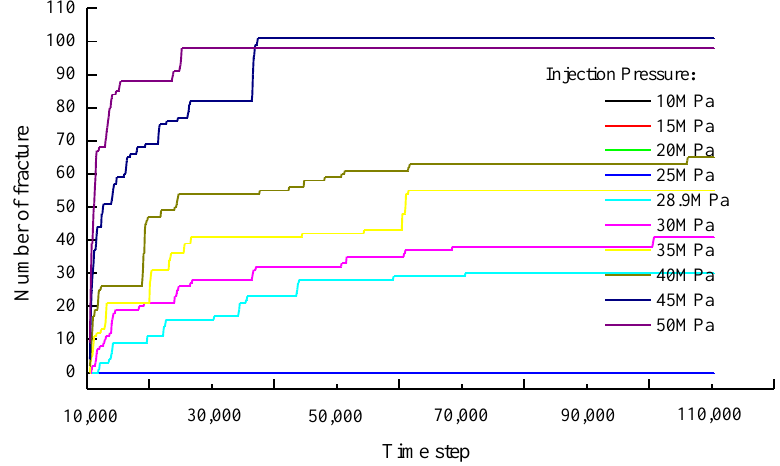
Figure 5. The number of micro-fractures with the time variation of the sub-step for the injection